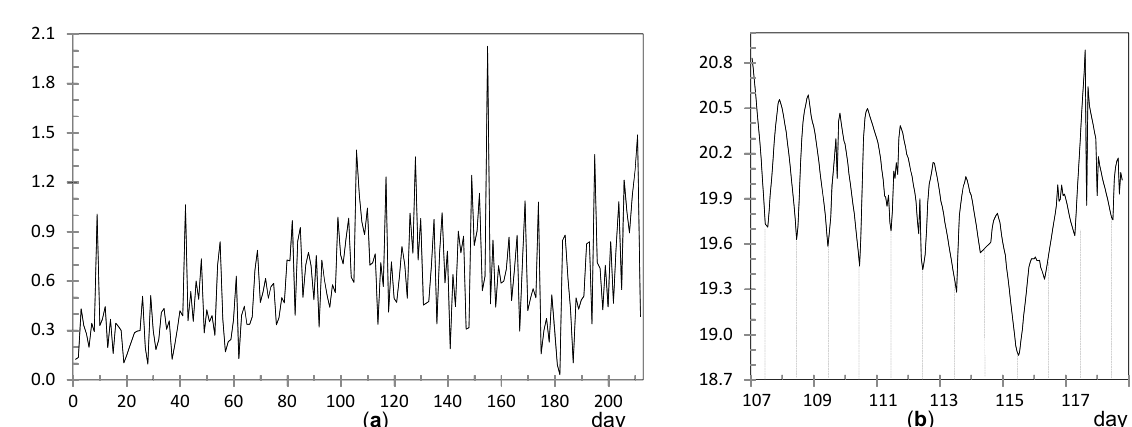
Figure 12. Node EN3: ( a ) time series of daily ranges of temperature ( ° C) for the 212 days, ( b ) time series of hourly values of temperature from day 107 to 118 (15 to 26 of November).